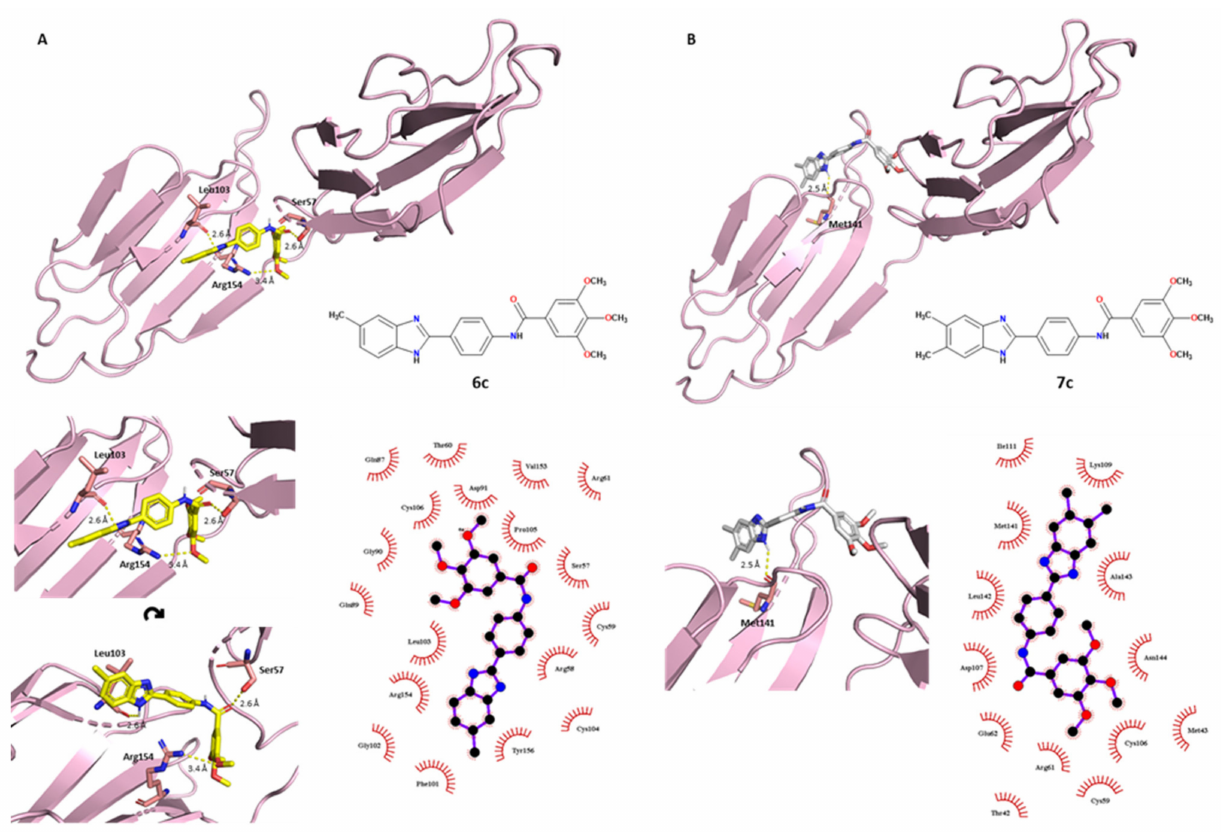
Figure 5. PyMOL (3D) and LigPlot + (2D) representations showing polar and nonpolar interactions between the E2 protein and ( A ) compounds 6c and ( B ) 7c . Compounds 6c and 7c are colored in yellow and white,